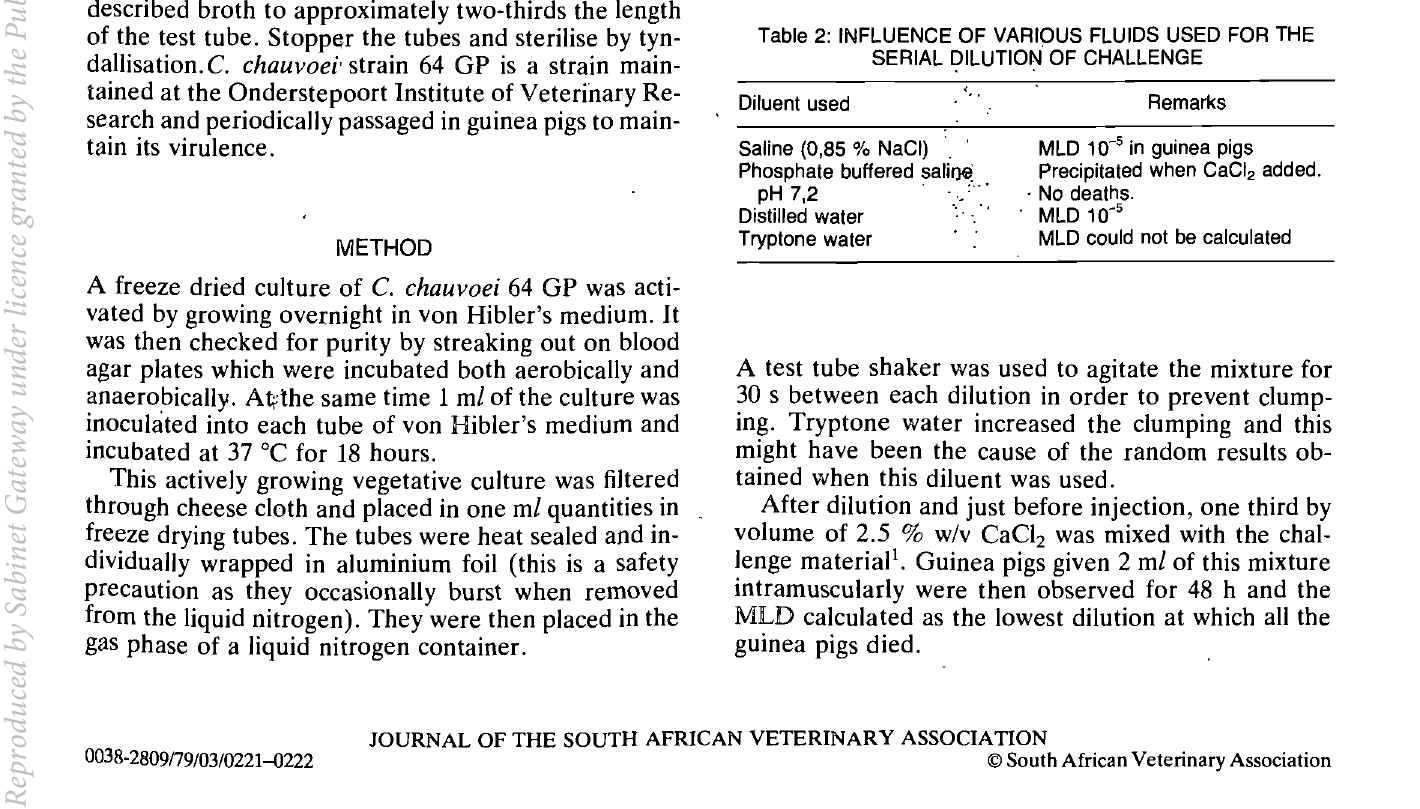
Table 2: INFLUENCE OF VARIOUS FLUIDS USED FOR THE SERIAL I?ILUTION OF CHALLENGE Diluent